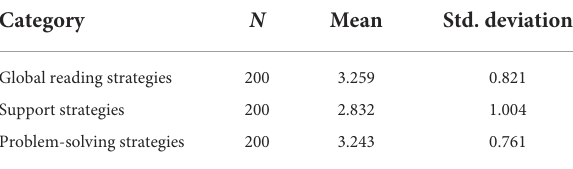
TABLE 9 Levels of metacognitive awareness of reading in learners. TABLE 10 Effect of reading metacognitive awareness on